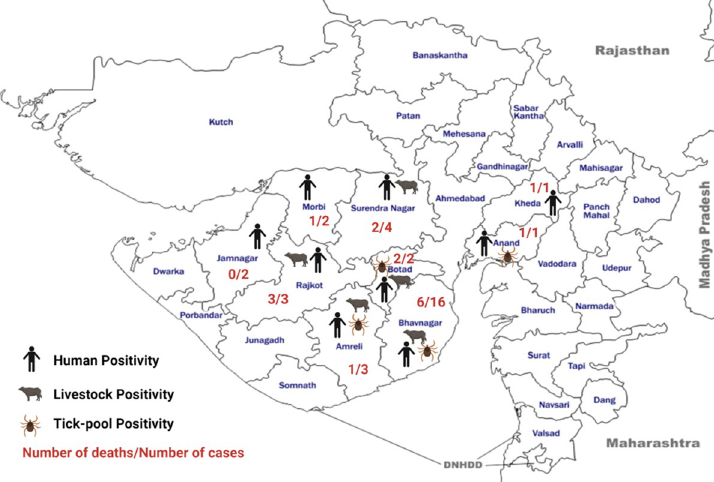
Fig 1. District-wise CCHF positivity in the humans, tick-pools and livestock from Gujarat State, India during the year 2019. Image attribution: https://d-maps.com/carte.php?num_car=8623&lang=en. License attribution: https://d- maps.com/conditions.php?lang=en. The map was modified showing the district-wise CCHF human cases, tick-pools and livestock positivity in the year 2019. All the details provided in the figure are created by the author themselves using the licensed version of the online software